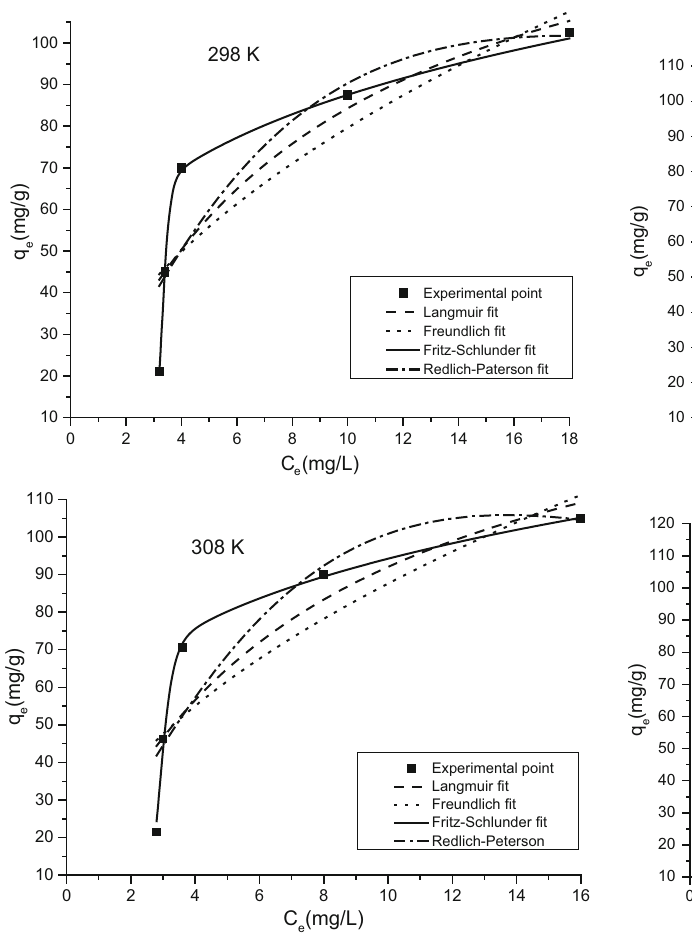
Fig. 9 Experimental points and non-linear fitted curves from isotherm